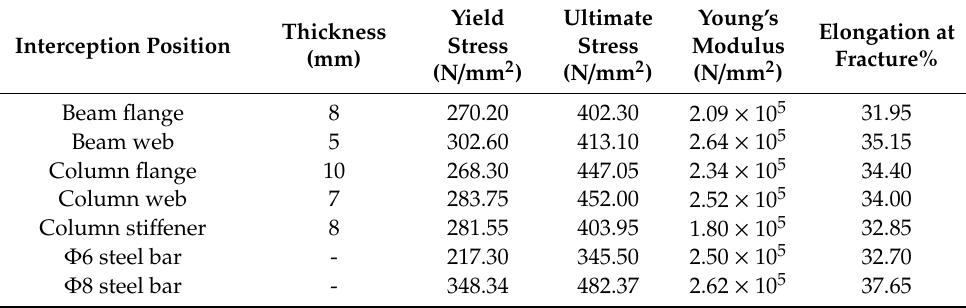
Table 2. Mechanical properties of steel.